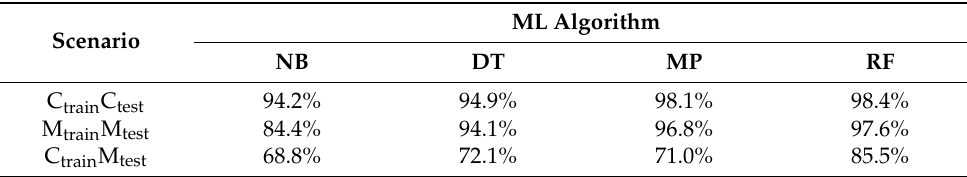
Table 4. Accuracy of DT and RF in different scenarios.